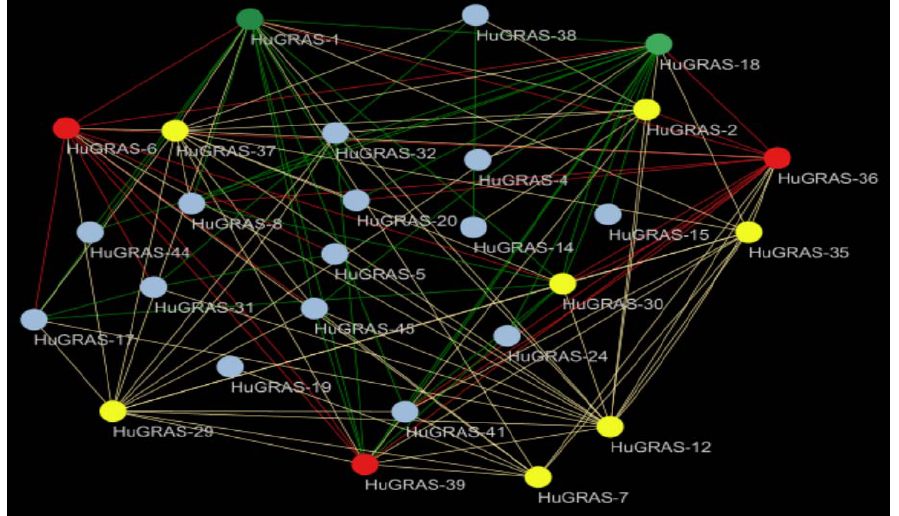
Figure 6. Protein interaction network. Green and red genes are designated as hub genes because they interact with more than 10 genes. Different colors show the interactions of the genes as follows: green (16–20), red (11–15), yellow (6–10) and gray (2–5).